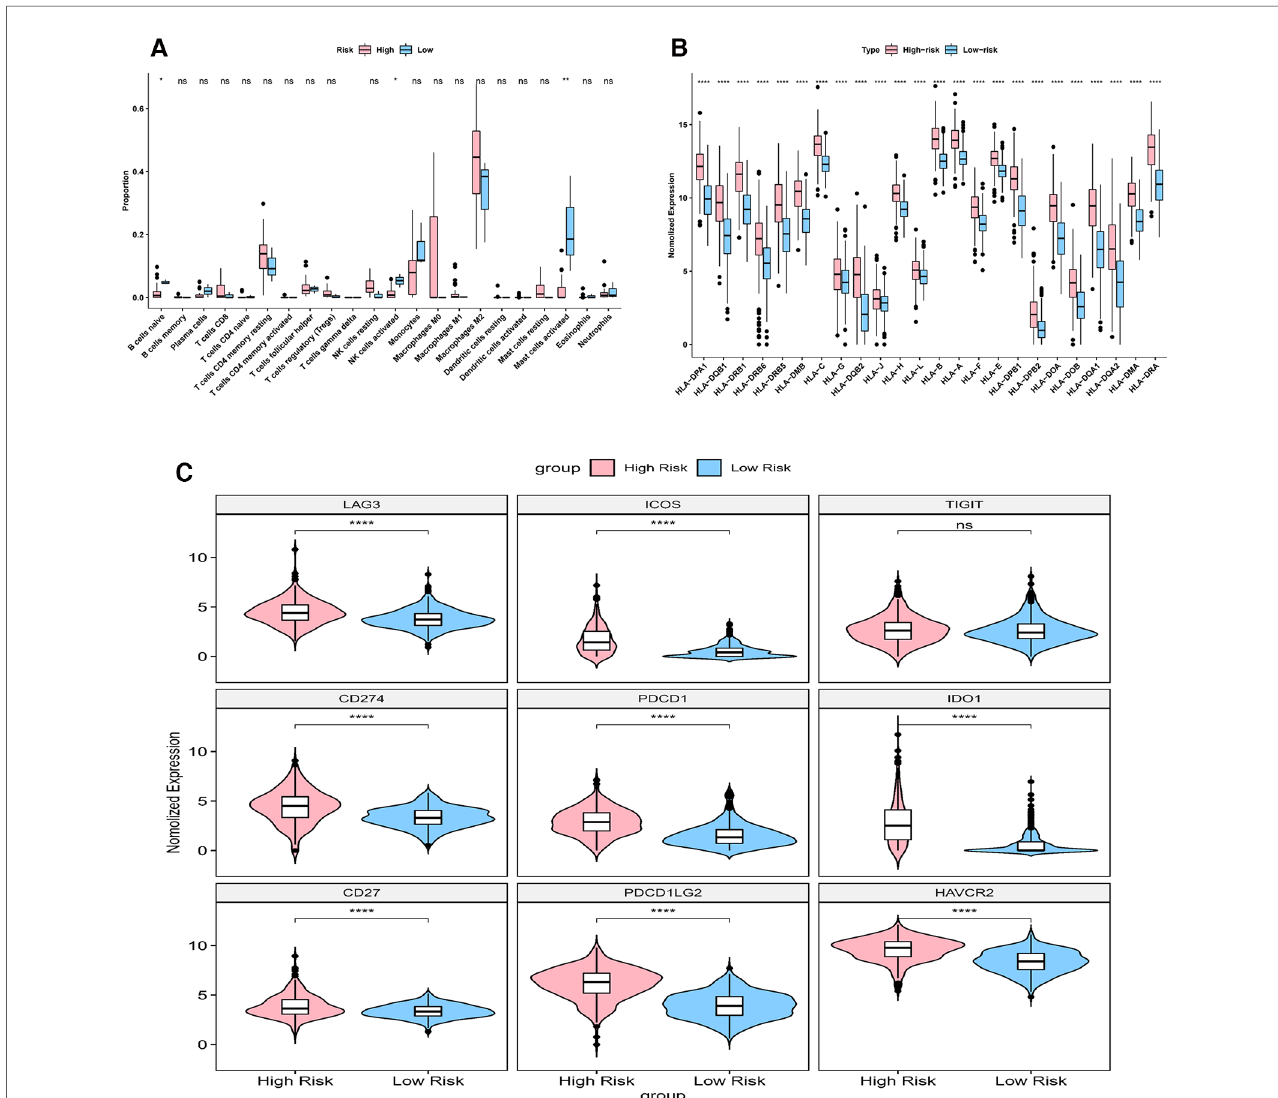
FIGURE 10 Impact of risk model on immune heterogeneity ( A ) the box line plots comparing the difference of immune cells between high and low risk groups. ( B ) The box line plots comparing the difference of HLA between high and low risk